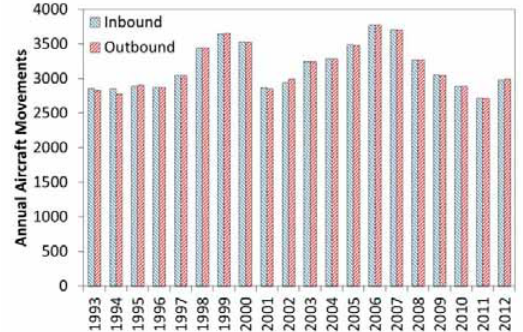
Fig. 4. Annual RPT aircraft movements at Mildura Airport: